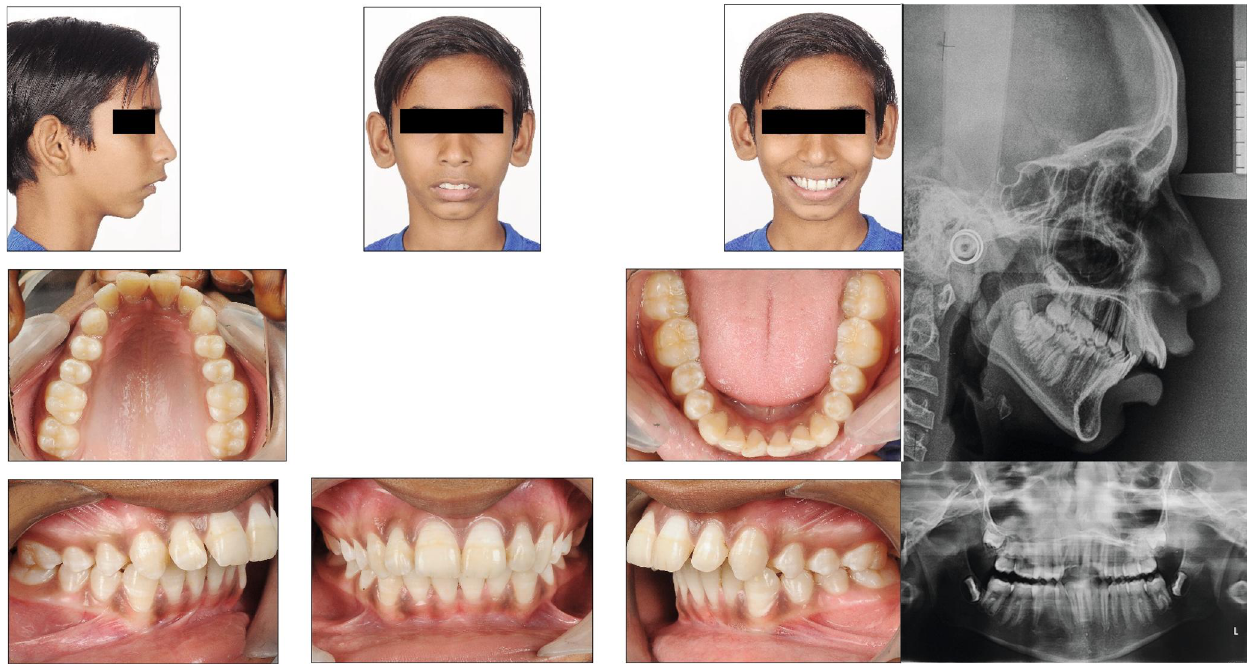
Figure 1: Pretreatment photographs and